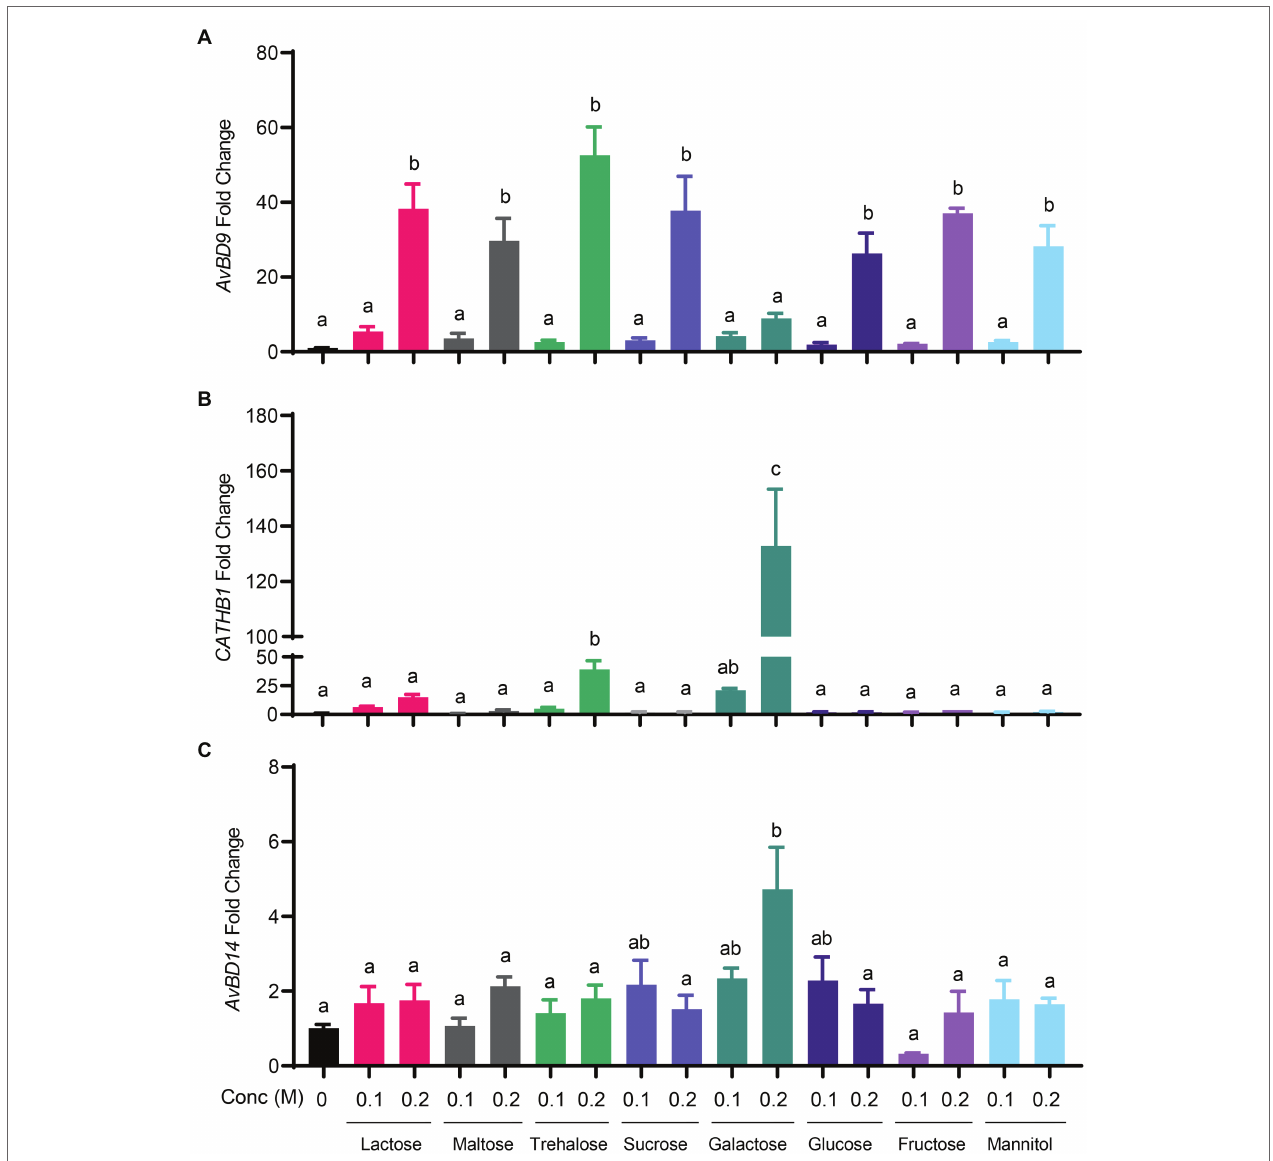
FIGURE 3 | Dose-dependent induction of chicken HDP expression by sugars. Chicken HD11 macrophage cells were stimulated in duplicate with 0.1 or 0.2 M of indicated sugars for 6 h, followed by RNA isolation and RT-qPCR analysis of the gene expressions of AvBD9 (A) , CATHB1 (B) , and AvBD14 (C) . Results are expressed as means ± SEM of 2–3 independent experiments. The bars without common superscript letters denote statistical significance ( p < 0.05) as determined by one-way ANOVA and post hoc Tukey’s